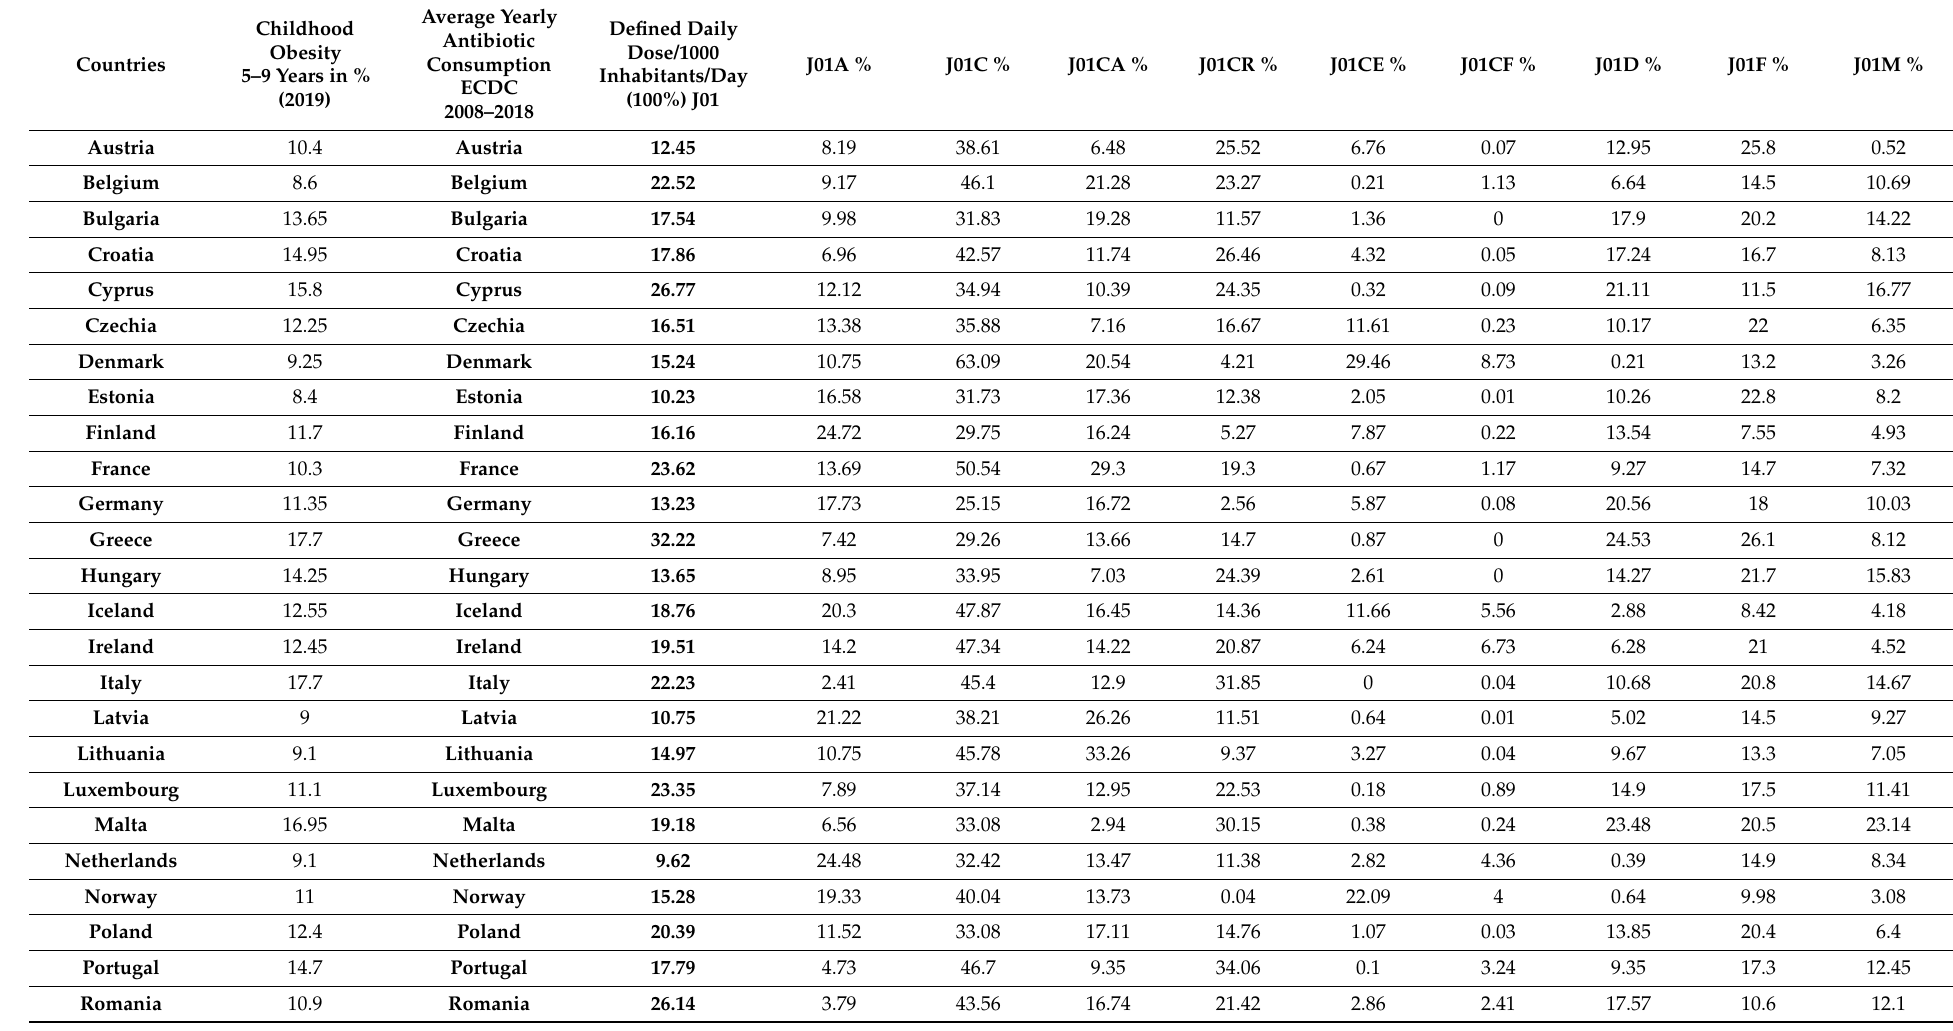
Table 1. Prevalence of childhood obesity compared to the antibiotic consumption data, and the results of the